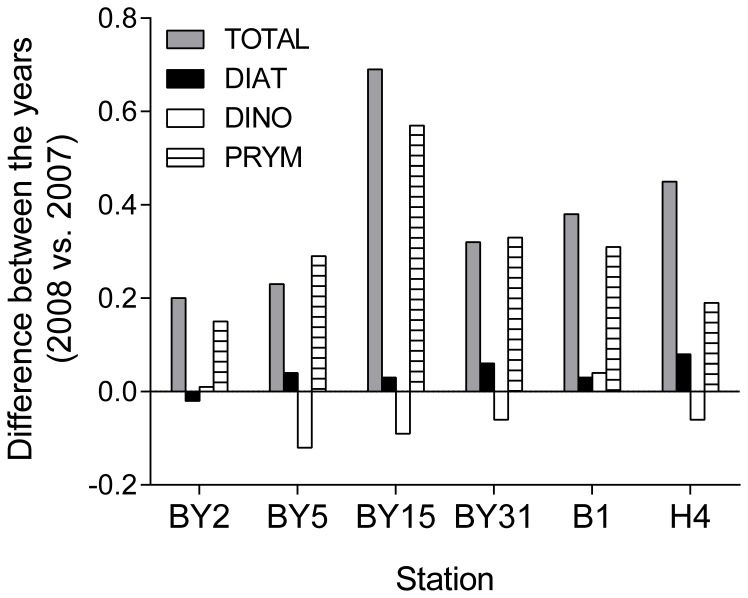
Differences in phytoplankton biovolumes (mm3 L−1) in January-June between the year 2008 and 2007.Abbreviations: DIAT - Diatoms, DINO - Dinoflagellates, PRYM - Prymnesiales. Stations are ordered south to north.